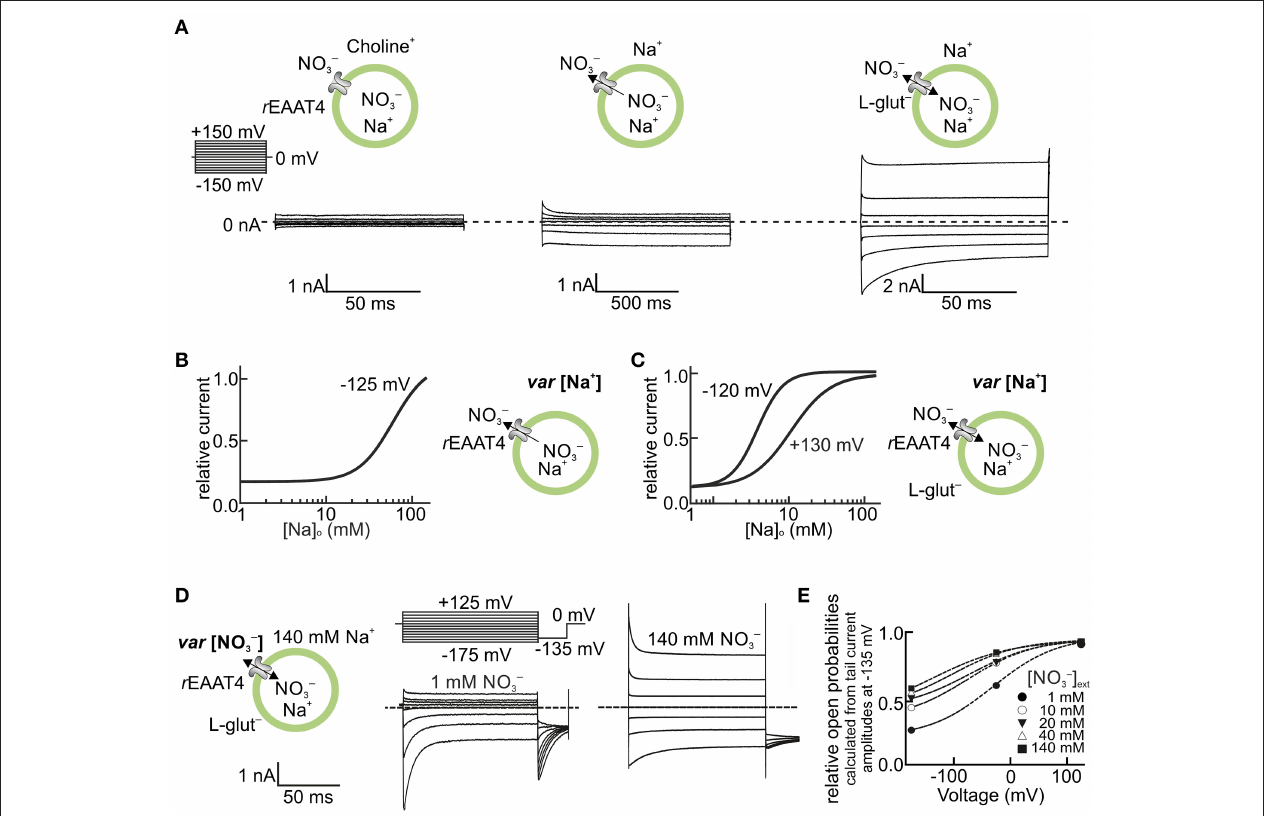
FIGURE 1 | EAAT anion channels are modulated by transport substrates and permeant anions. (A–C) Na + dependence of EAAT4 anion channels heterologously expressed in HEK293T cells. (A) Representative whole-cell current recordings of rat EAAT4 with symmetric NO + 3 as the permeable anion, in the absence of external Na + and L-glutamate (Glu − ) (left), in the presence of external Na + (middle), and in the presence of external Na + and 5mM L-glutamate (right, see insets). The Na + concentration dependence of EAAT4 anion channel currents is shown in the absence (B) and presence (C) of external L-glutamate for high positive and negative voltages (internal Na + concentration in A,B was set to ∼ 114mM). (D,E) Dependence of EAAT4 anion channel gating on permeant anions. (D) Representative whole-cell recordings from rat EAAT4 whole-cell currents with different external concentrations of NO + 3 (1–140mM) (see insets, the internal NO + 3 concentration in C,D was set to 110mM). (E) Relative open probabilities of rat EAAT4 anion channels at different external concentrations of the permeant anion NO + 3 . In the depicted experiments, Na + was replaced by equimolar amounts of choline (A–C) , and NO + 3 by the impermeant anion D-gluconate − (D,E) . Relative open probabilities in E were calculated from instantaneous tail current amplitudes at − 135mV, as shown in the voltage protocol in D. rEAAT4: rat EAAT4. var, varying. This figure is modified and reprinted from Kovermann et al. (2010), with